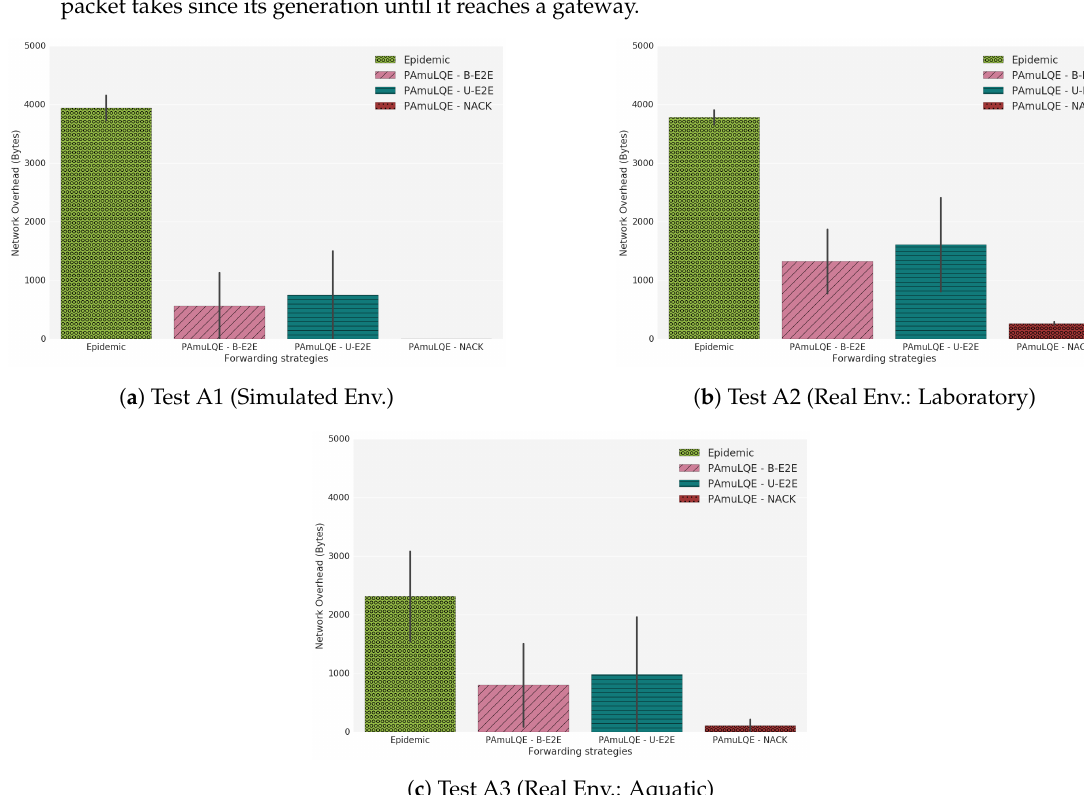
Figure 23. Network Overhead for Scenario A. The bar plots represent the amount of redundant data packets that each strategy introduces in the